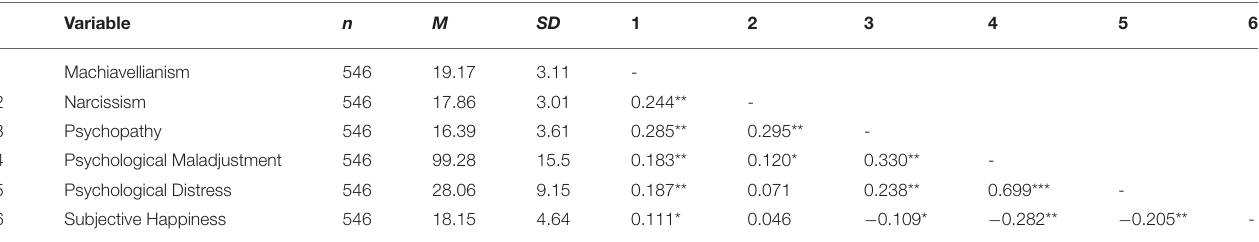
TABLE 3 | Descriptive statistics and partial correlation of study variables.